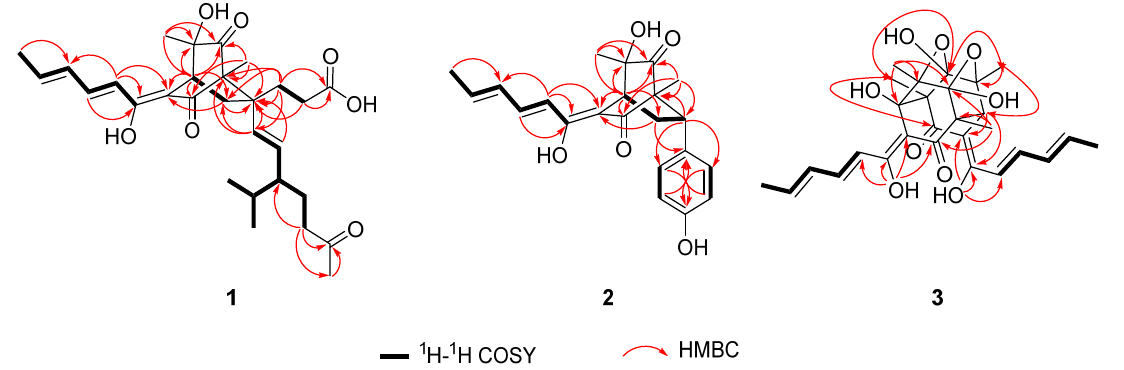
Figure 2. Key COSY and HMBC correlations of compounds 1 – 3 .